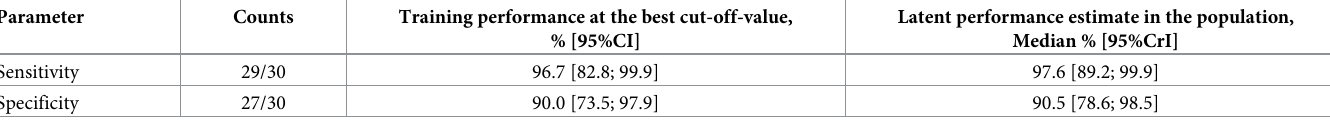
Table 3. Bayesian estimation of the latent diagnostic performance of HpAfr-ELISA in the absence of a perfect gold standard test. Parameter